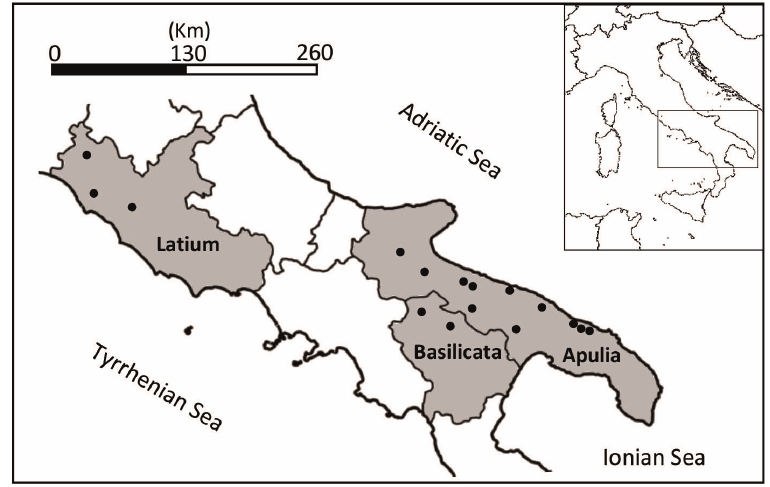
Figure 1. Studied area and water sampling sites (dots).